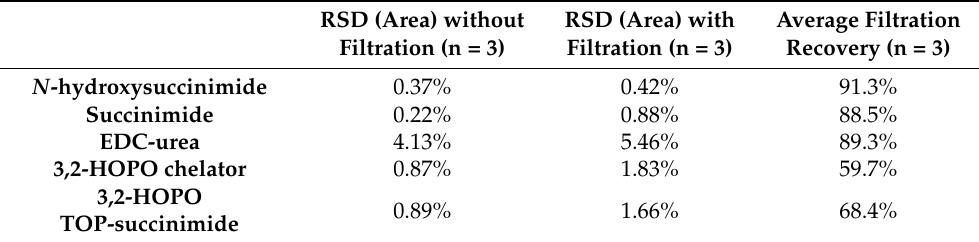
Table 1. Investigation of the filtration protocol effects for the 5 impurities spiked in an ACC sample ( N -hydroxysuccinimide and Succinimide at 10 µ g mL − 1 + EDC-urea, 3,2-HOPO chelator, and TOP-